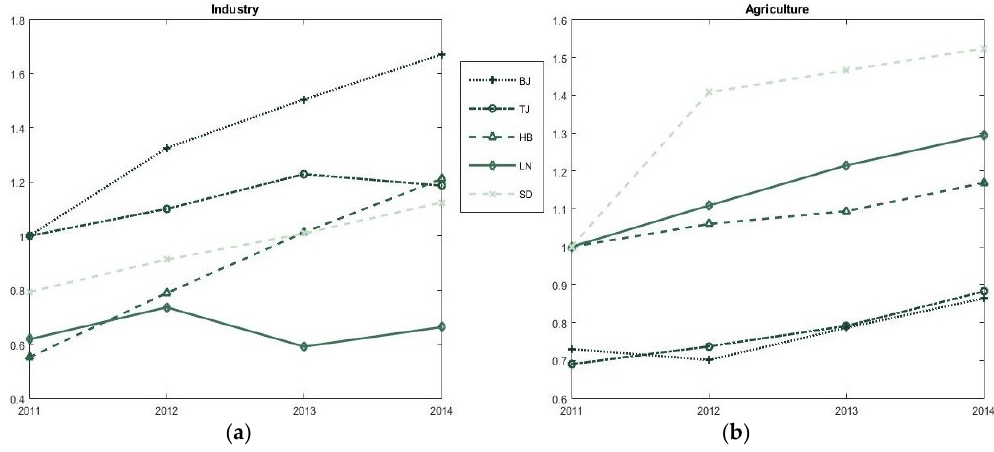
Figure 2. ( a ) shows changes in industrial water use efficiency among sub regions in Bohai Bay Region; ( b ) shows changes in agricultural water use efficiency among sub regions in Bohai Bay